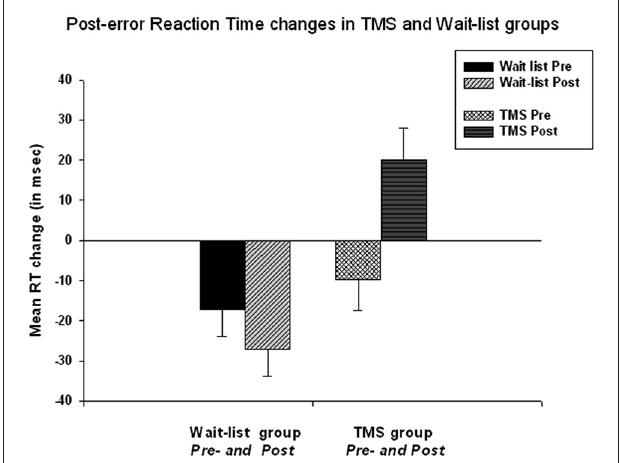
FIGURE 2 | Post-error reaction time (RT) changes in TMS and wait-list groups at the baseline and at the second test . Time X Group effect is highly significant ( F = 8.05, p = 0.006). At the baseline both groups showed post-error RT speeding, while post-TMS post-error RT became positive. Change of the post-error RT in TMS group was significant ( t = 4.57, p < 0.001).